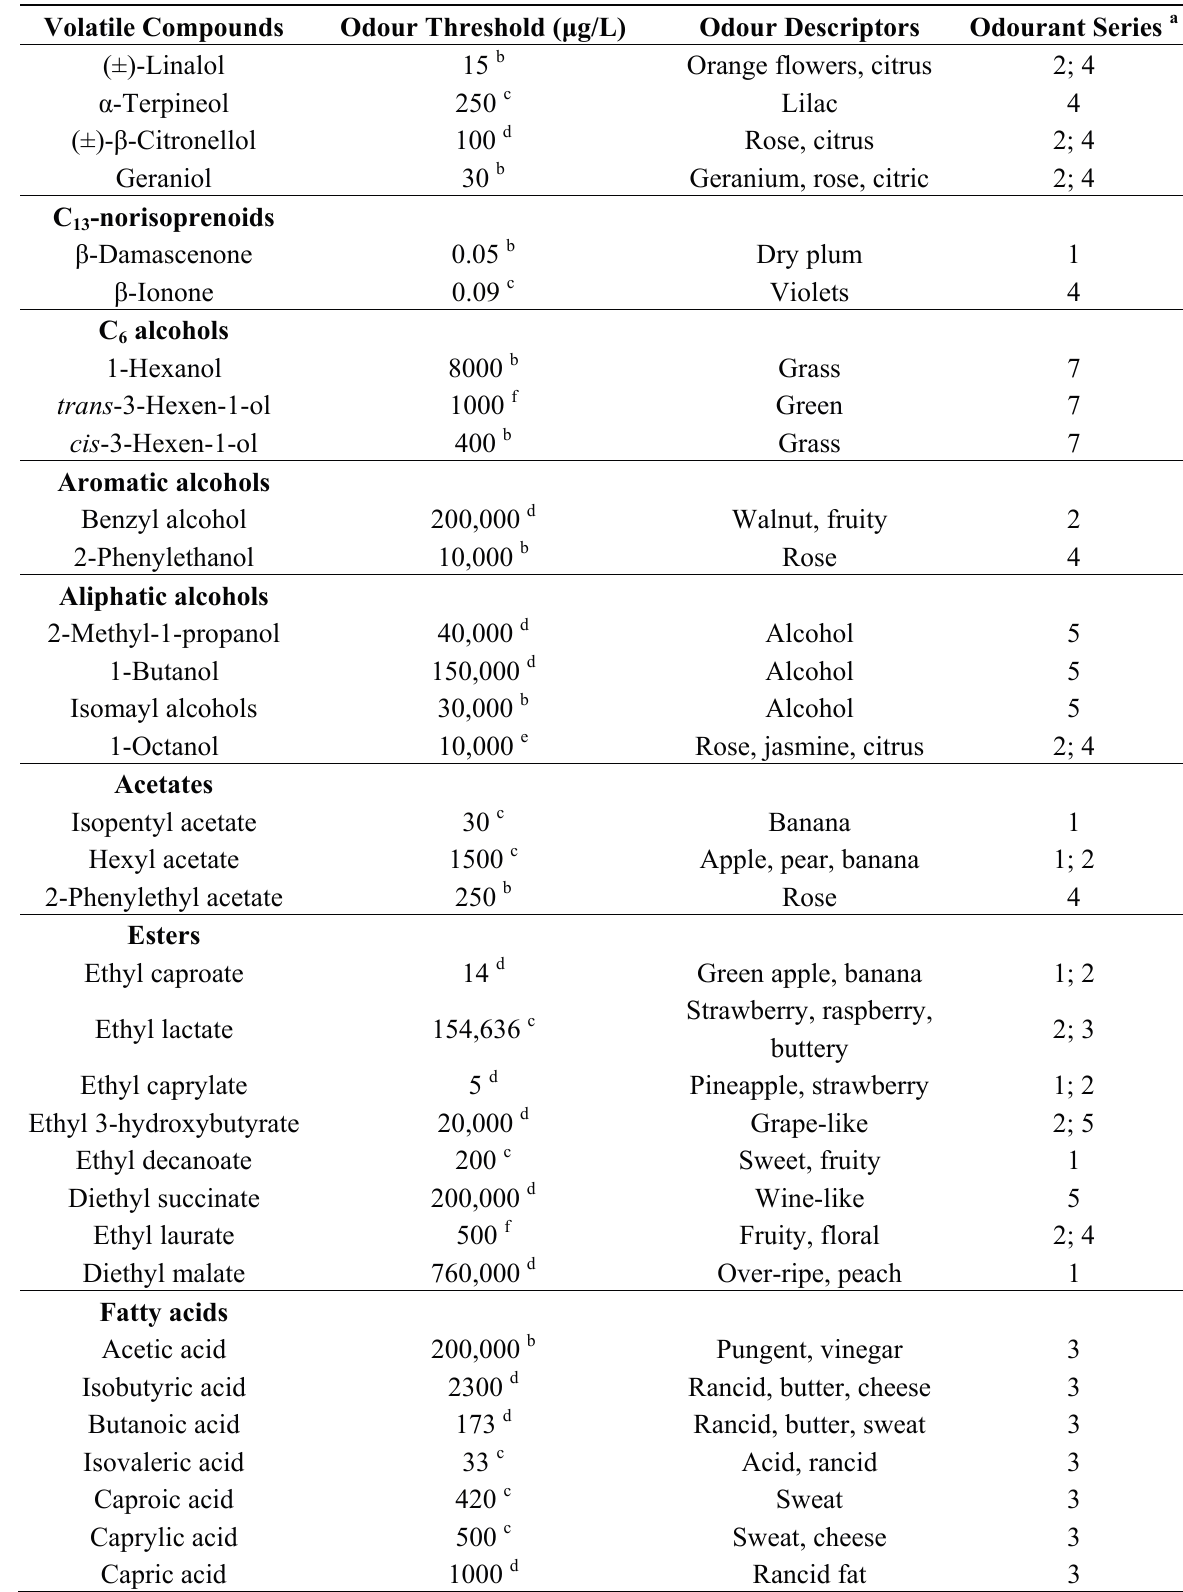
Table 2. Classification of volatile compounds into odourant series according to their odour descriptors. Volatile